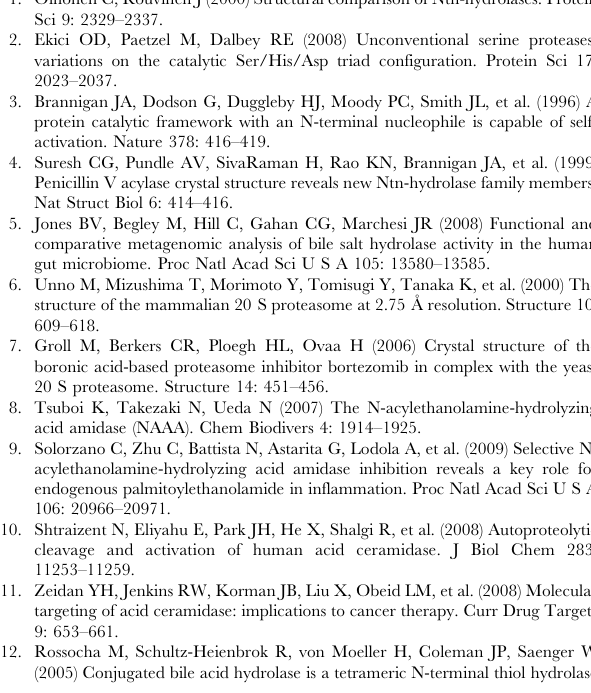
Table S1 pKa prediction of titrable sites in CBAH by PROPKA. Table S2 PROPKA contributions to the final pKa